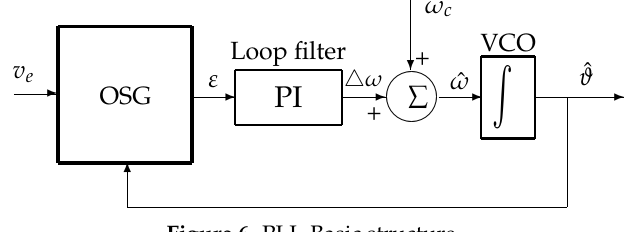
Figure 6. PLL-Basic structure.